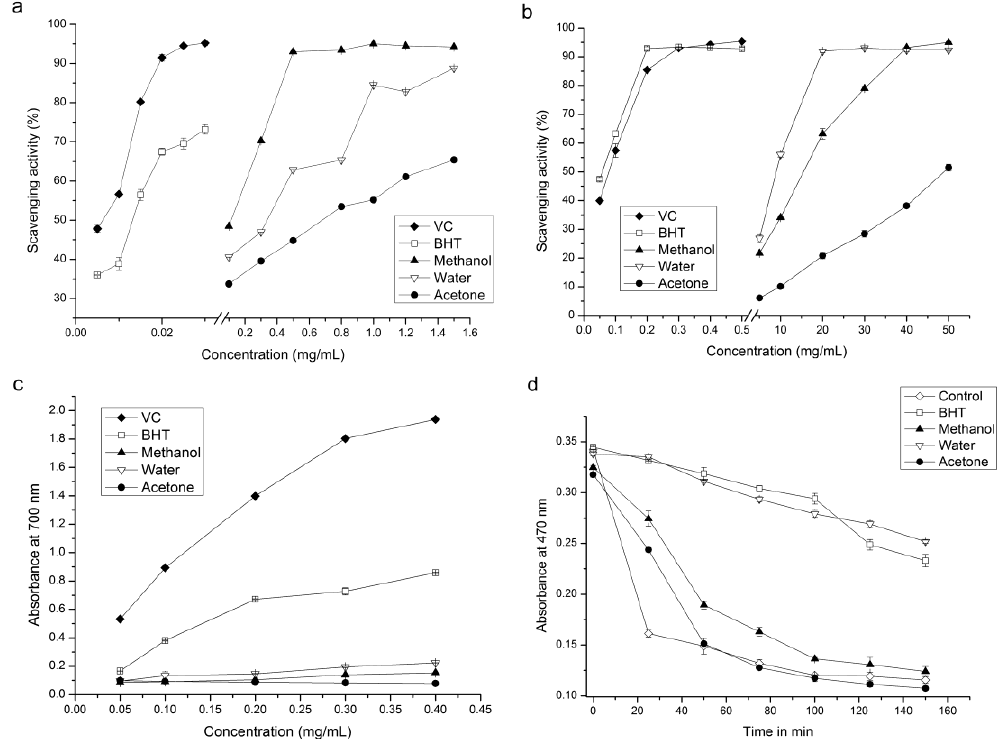
Figure 2. Antioxidant activity assays of ICM extract. ( a ) DPPH radical scavenging activity, ( b ) ABTS radical scavenging activity, ( c ) reducing power, ( d ) β -carotene/linoleic acid cooxidation activity.